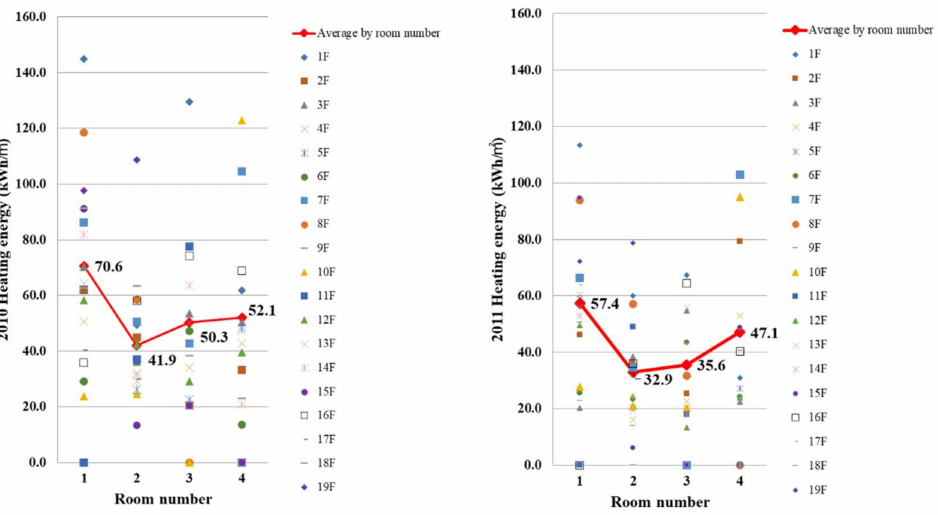
Figure 10. Distribution and measured average heating energy in 2010 and 2011 by room number.